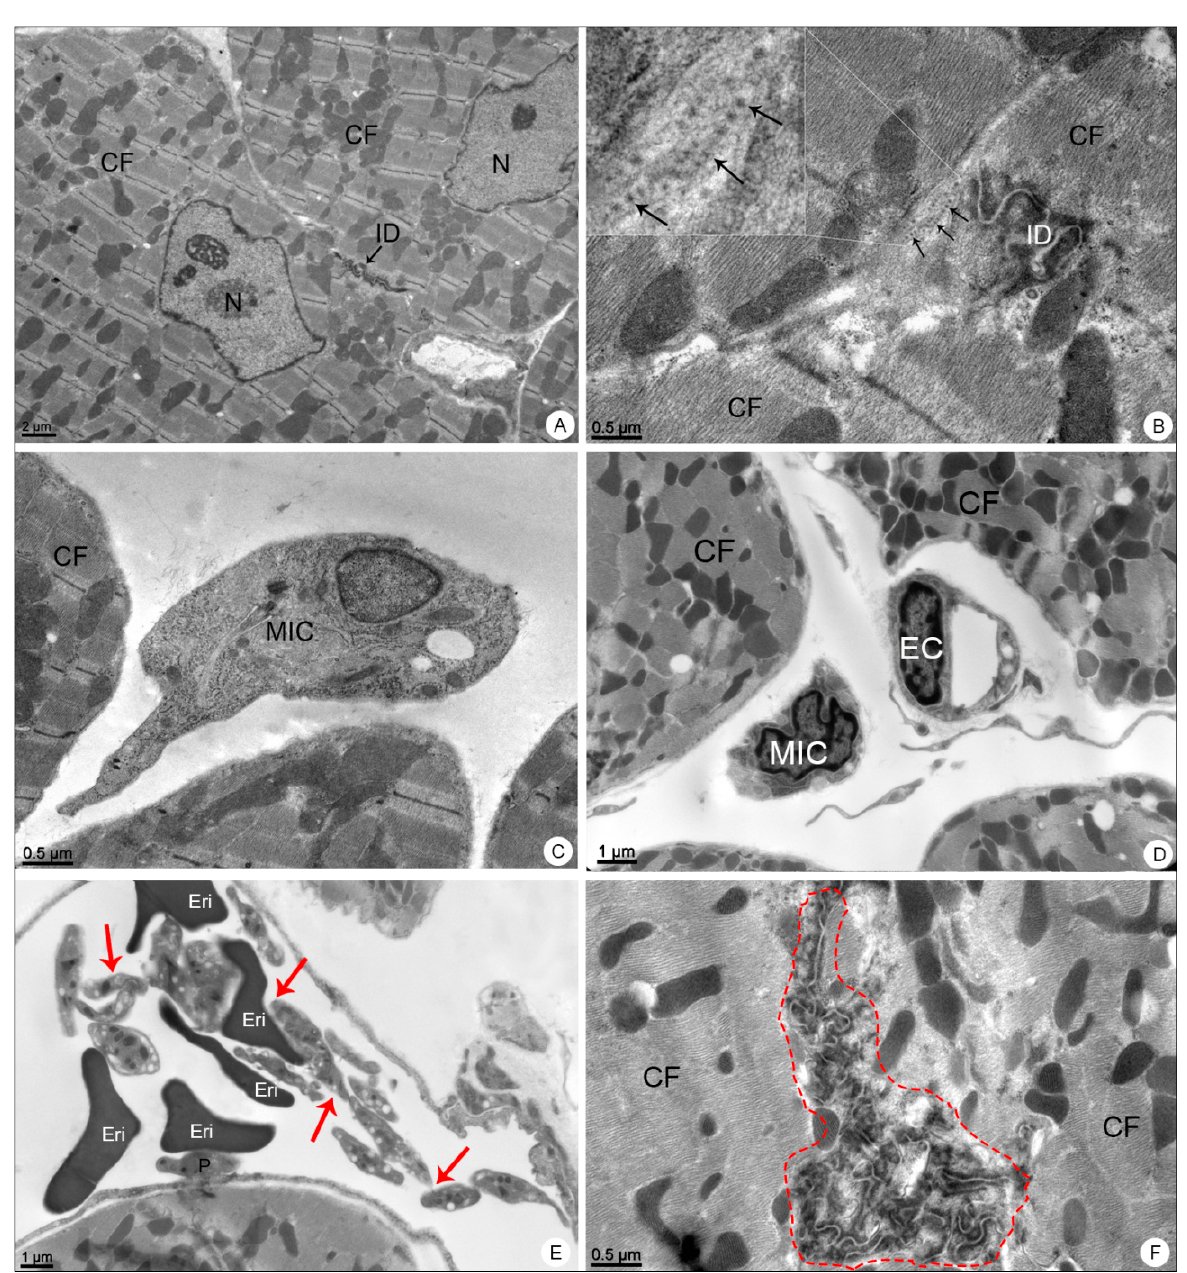
Figure 7. Heart samples of BALB/c mice observed in transmission electron microscope. ( A ) Negative control sample. Cardiac fibers (CF); nucleus (N); intercalated disc (ID). ( B – F ) DENV-4-infected samples. Dengue virus-like particles (arrows); intercalated disc (ID); mononuclear inflammatory cell (MIC); platelet aggregation (red arrows); platelet adhered to the erythrocyte (E), endothelium (P); capillary (C); intercalated disk disorganization (dashed outline). Magnification: ( A ) = 5000×; ( B ) = 30,000×, ( C ) = 15,000×; ( D ) = 12,000×; ( E ) = 10,000×; ( F ) = 20,000×.